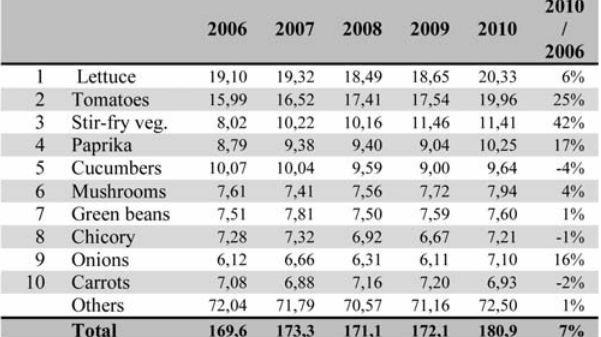
Table 3. Top 10 Domestic purchases fresh vegetables (in € per